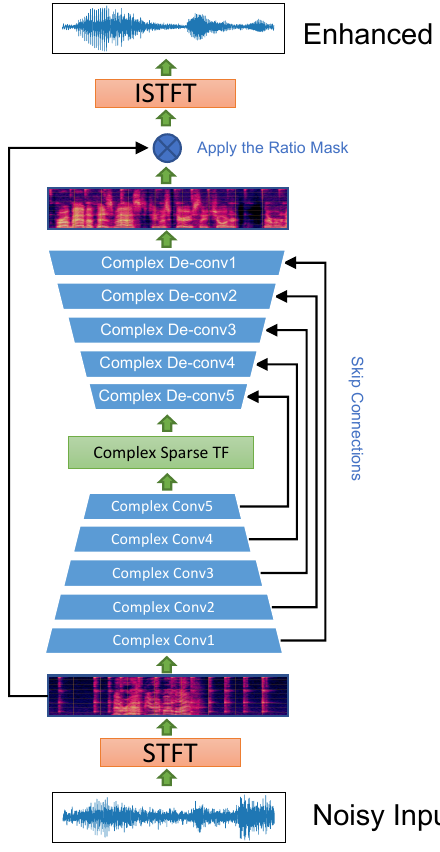
Figure 1. Model overall